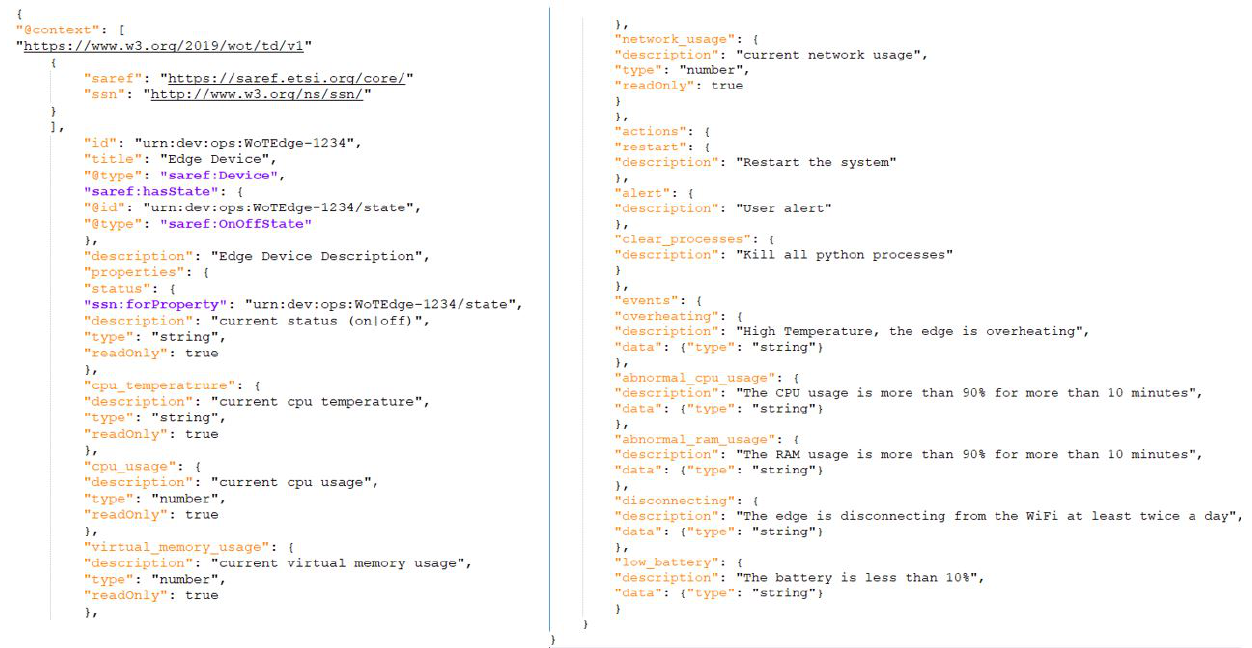
Figure 11. Example of the description of SEDGE devices in